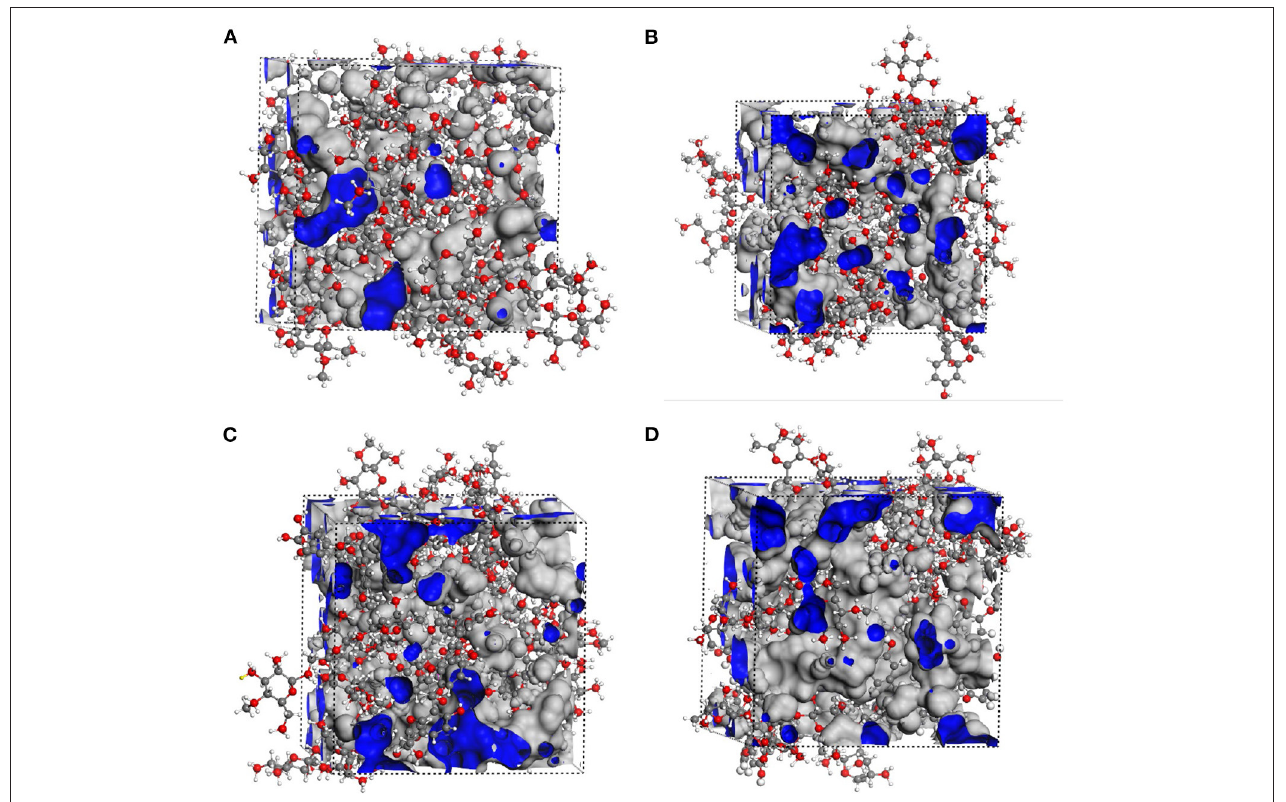
FIGURE 9 | Free volume distribution of RS with or without LSOPC, 0PC S (A) , 1PC S (B) , 2PC S (C) , and 3PC S (D)